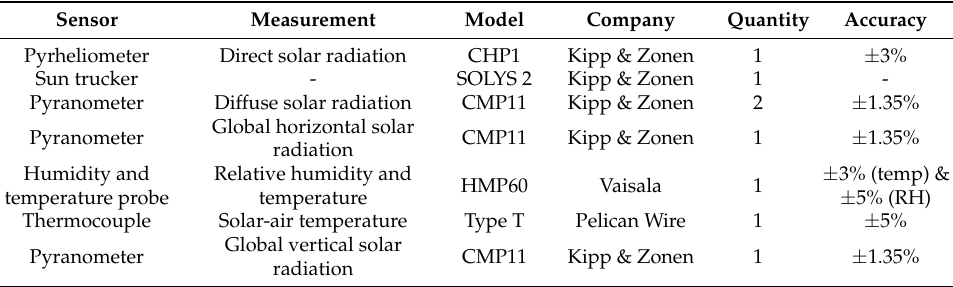
Table 4. List of sensors of meteorological station and for outdoor